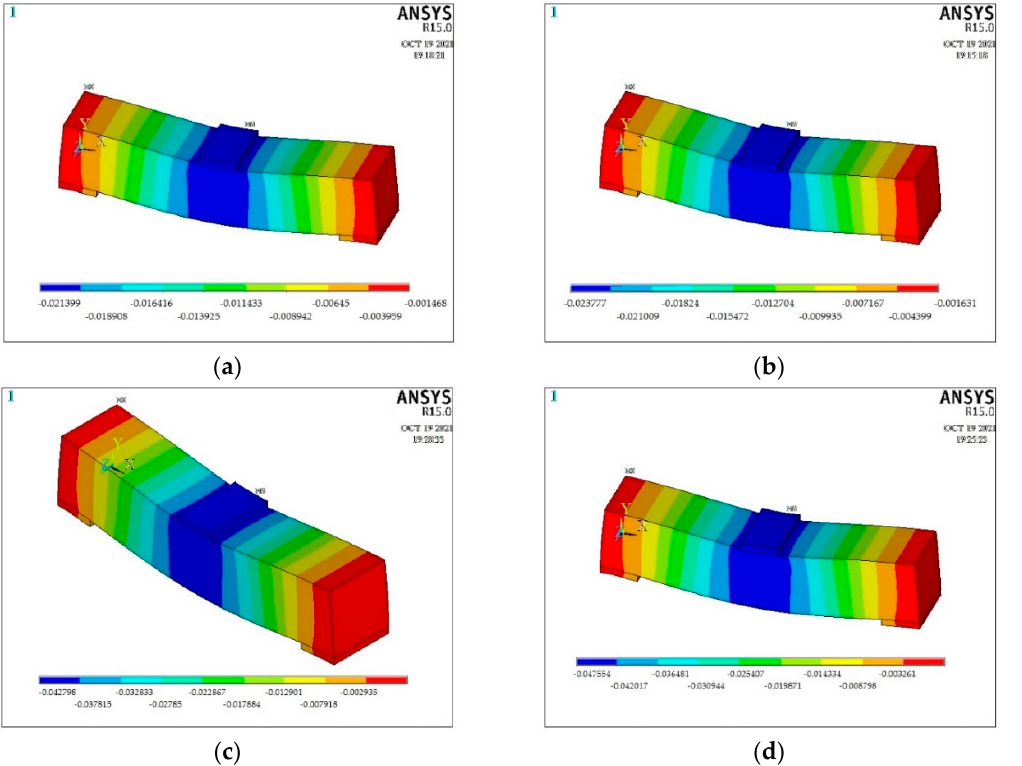
Figure 8. 3D views of the deflection patterns of typical beam models: ( a ) Rubber ratio = 0% (homo- geneous), ( b ) rubber ratio = 0% (heterogeneous), ( c ) rubber ratio = 20% (homogeneous), ( d ) rubber ratio = 20% (heterogeneous).